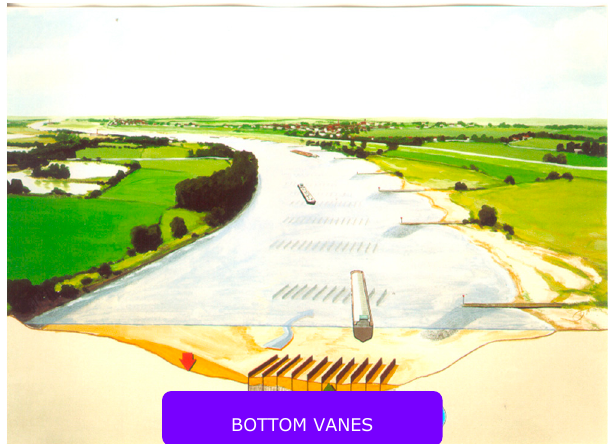
Figure 19. Impression of bottom vanes (copyright Kees Nuijten).